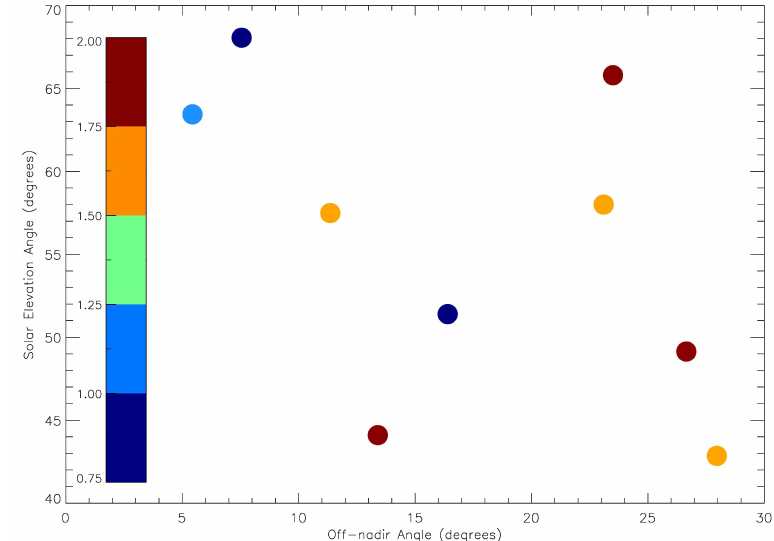
Figure 3. The solar elevation angles and off-nadir angles for the nine images listed in Table A1. Symbol colours provide the mean un-sharpened to pan-sharpened spectral ratio (plotted in Figure 2) across bands 1 to 5 (visible wavelengths). A weak positive correlation is observed between the magnitude of the spectral distortions and the degrees off-nadir (Pearson correlation coefficient